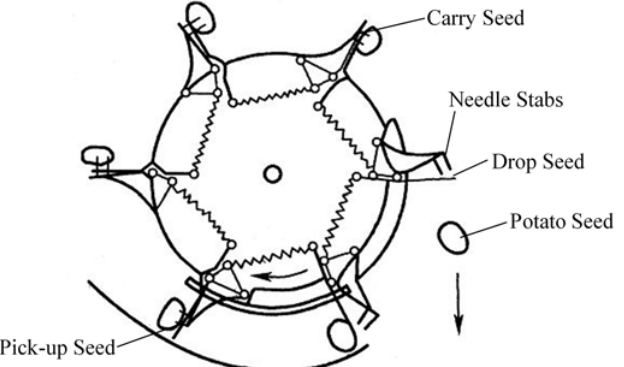
Figure 11. Needle-stabbed seed metering device. Reprinted with permission from ref. [31]. Copyright 2019 Chinese Society for Agricultural Machinery.